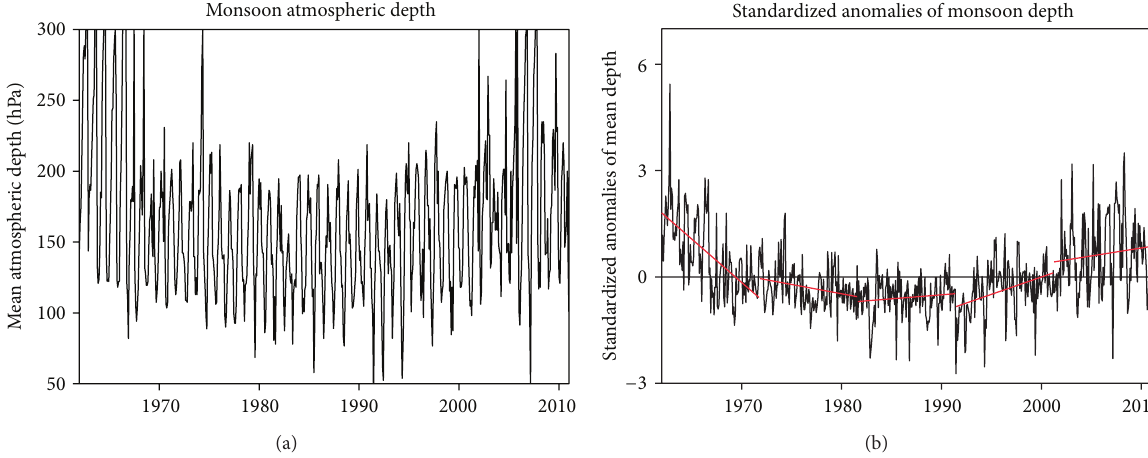
Figure 6: (a) Mean atmospheric depth of the monsoon flow at Lamto calculated from the difference between 1000 hPa and the atmospheric level reached by the monsoon flow coming from the ocean. (b) Standardized anomalies of the atmospheric depth of the monsoon calculated